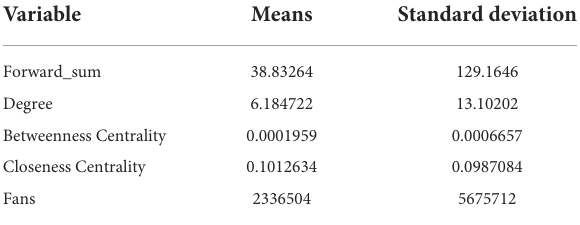
TABLE 6 Description of social network analysis indicators.